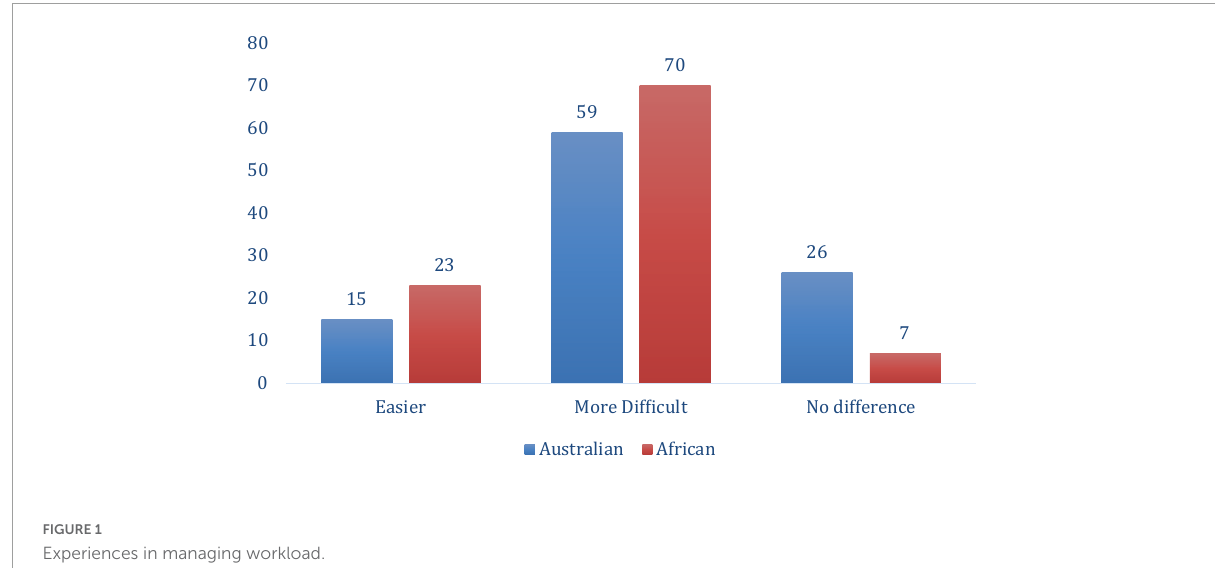
FIGURE1 Experiences in managing